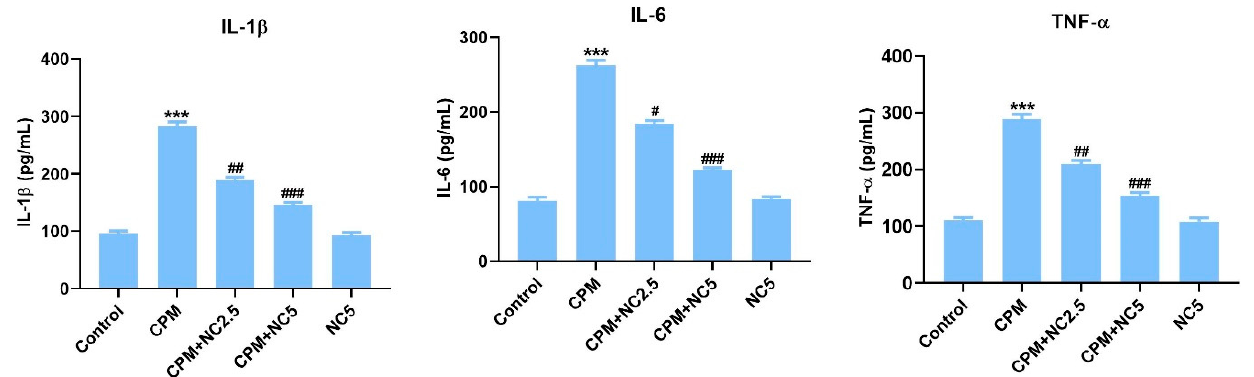
Figure 2. Effect of NC treatment on IL-1 β , IL-6, and TNF- α against CPM-induced neurotoxicity. Value shown as mean ± SE (n = 6). *** p < 0.001 vs. control, # p < 0.05; ## p < 0.01; ### p < 0.001 vs. CPM group.